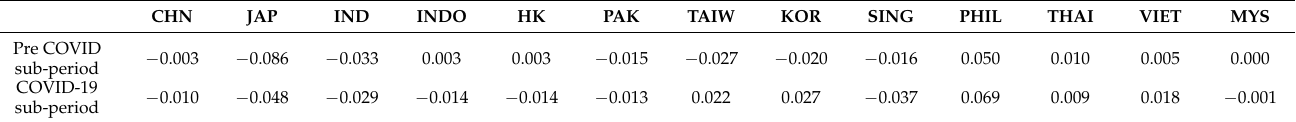
Figure 1. Dynamic conditional correlations (DCC). Table 1. Average dynamic conditional correlations.